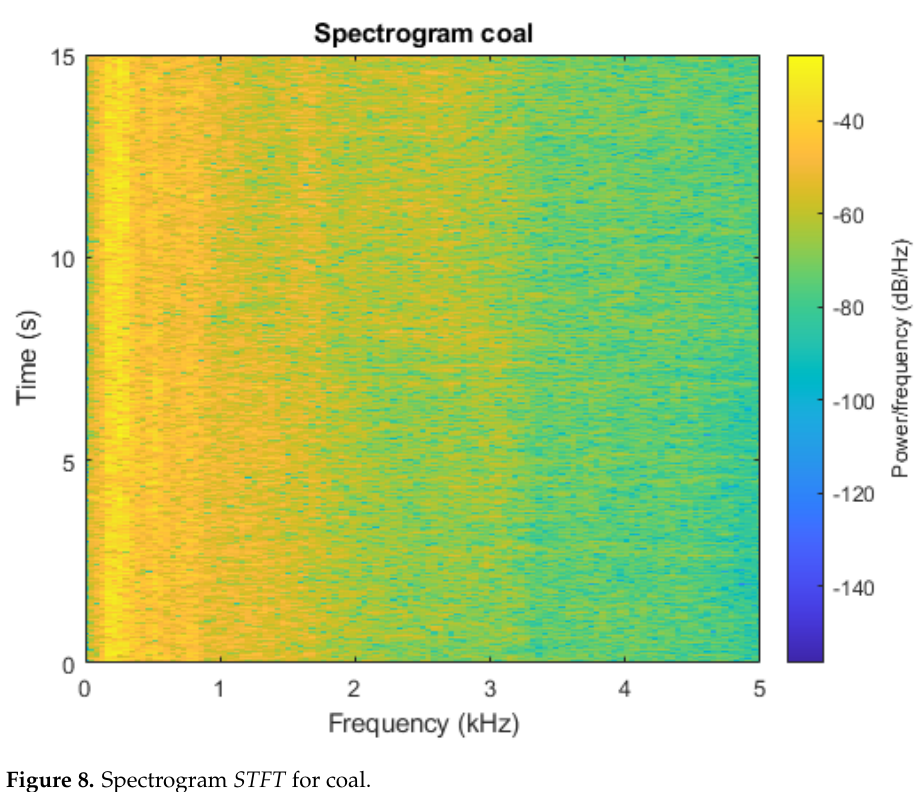
Figure 8. Spectrogram STFT for coal.